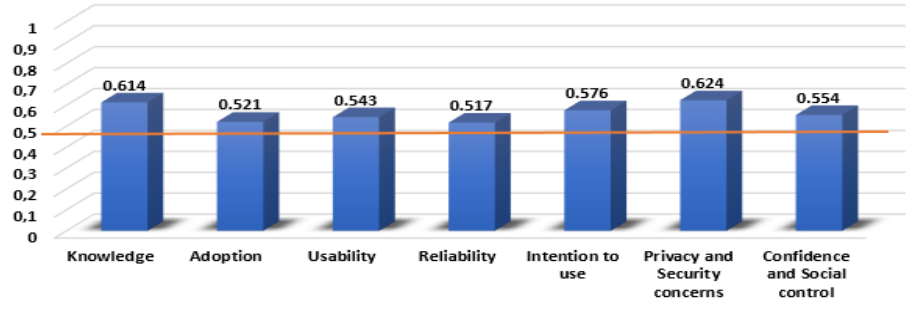
Figure 3. Average variance extracted .